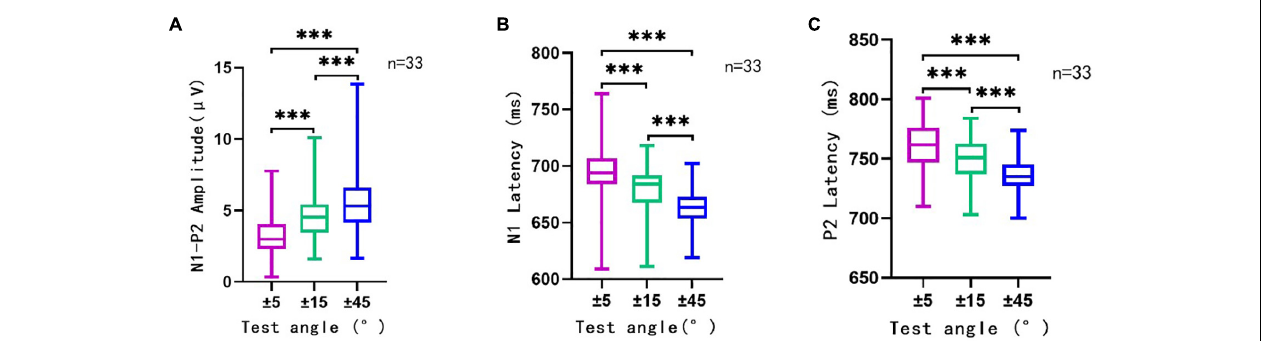
FIGURE 4 | The N1 (cid:48) –P2 (cid:48) amplitude (A) , N1 (cid:48) latency (B) , and P2 (cid:48) latency (C) in different conditions. This figure showed the N1 (cid:48) –P2 (cid:48) amplitude, N1 (cid:48) latency, and P2 (cid:48) latency of ACC elicited by sound direction change at 500 ms ( n = 33). Rightward and leftward location change-induced ACC at a certain angle were analyzed together as one group of data at that angle. The ordinate represented the amplitude (A) or latency (B,C) of ACC waveform. The abscissa represented different test angles. The purple line traced for a test angle change of ± 5 ◦ , the green line traced for that of ± 15 ◦ , and the blue line traced for ± 45 ◦ . Mean, SD, and extreme value of the N1 (cid:48) –P2 (cid:48) amplitude, N1 (cid:48) latency, and P2 (cid:48) latency are shown in this figure. It can be observed that with the increase in test angle, the N1 (cid:48) –P2 (cid:48) amplitude showed a growing trend, and the latency of N1 (cid:48) and P2 (cid:48) experienced a decreasing trend. There was a significant statistical significance ( p < 0.001) between different